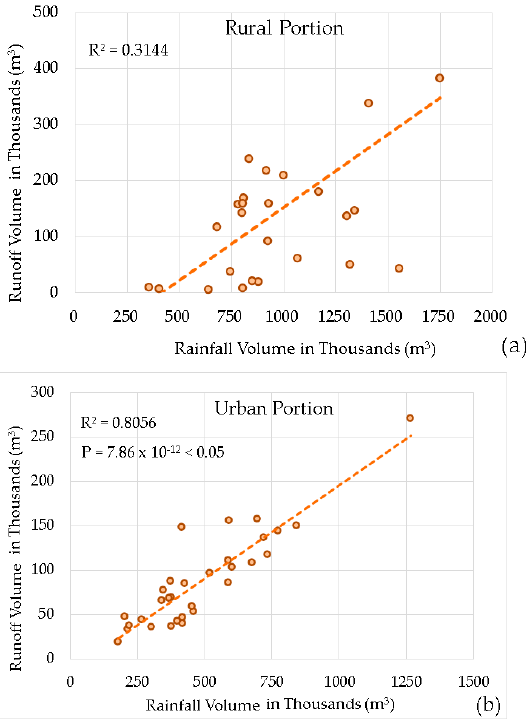
Figure 9. Rainfall and runoff relationships for the BHC ( a ) rural portion ( b ) urban portion.